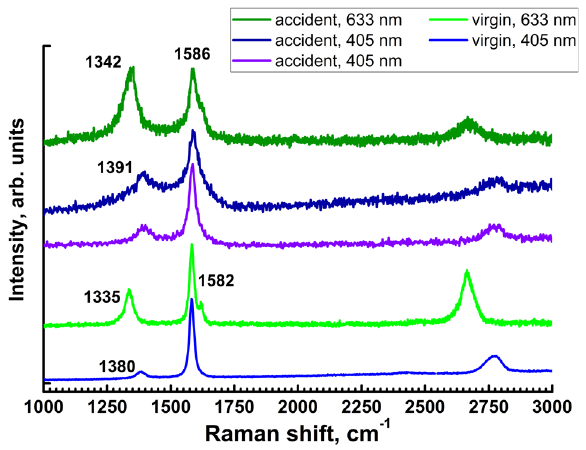
Fig. 3 Raman spectra of virgin GR-220 graphite and of the samples from fuel-contaminated volume. Spectra were recorded using 405 and 633 nm lasers; positions of D and G peaks is indicated. Spectra are displaced vertically for